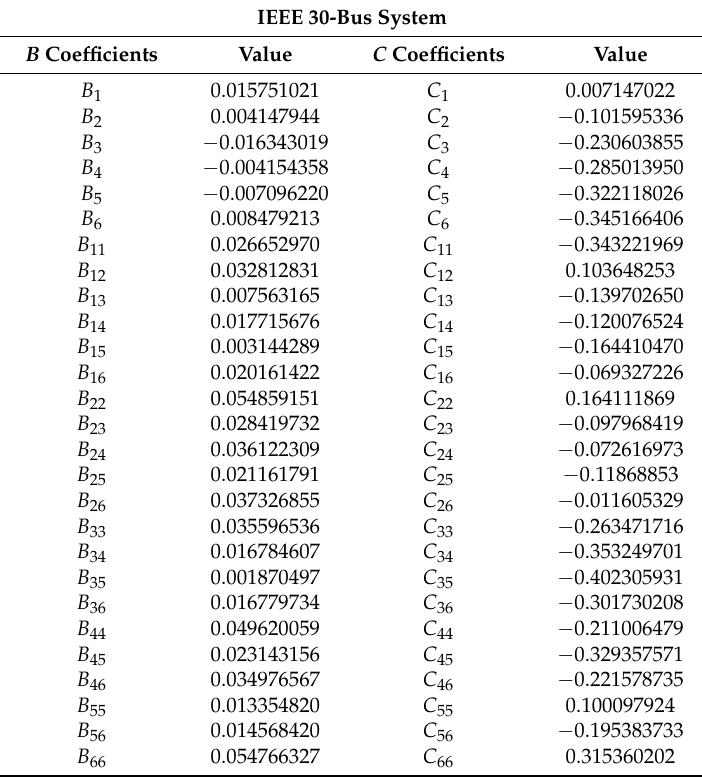
Table 2. New Loss Coefficients of the IEEE 30-bus